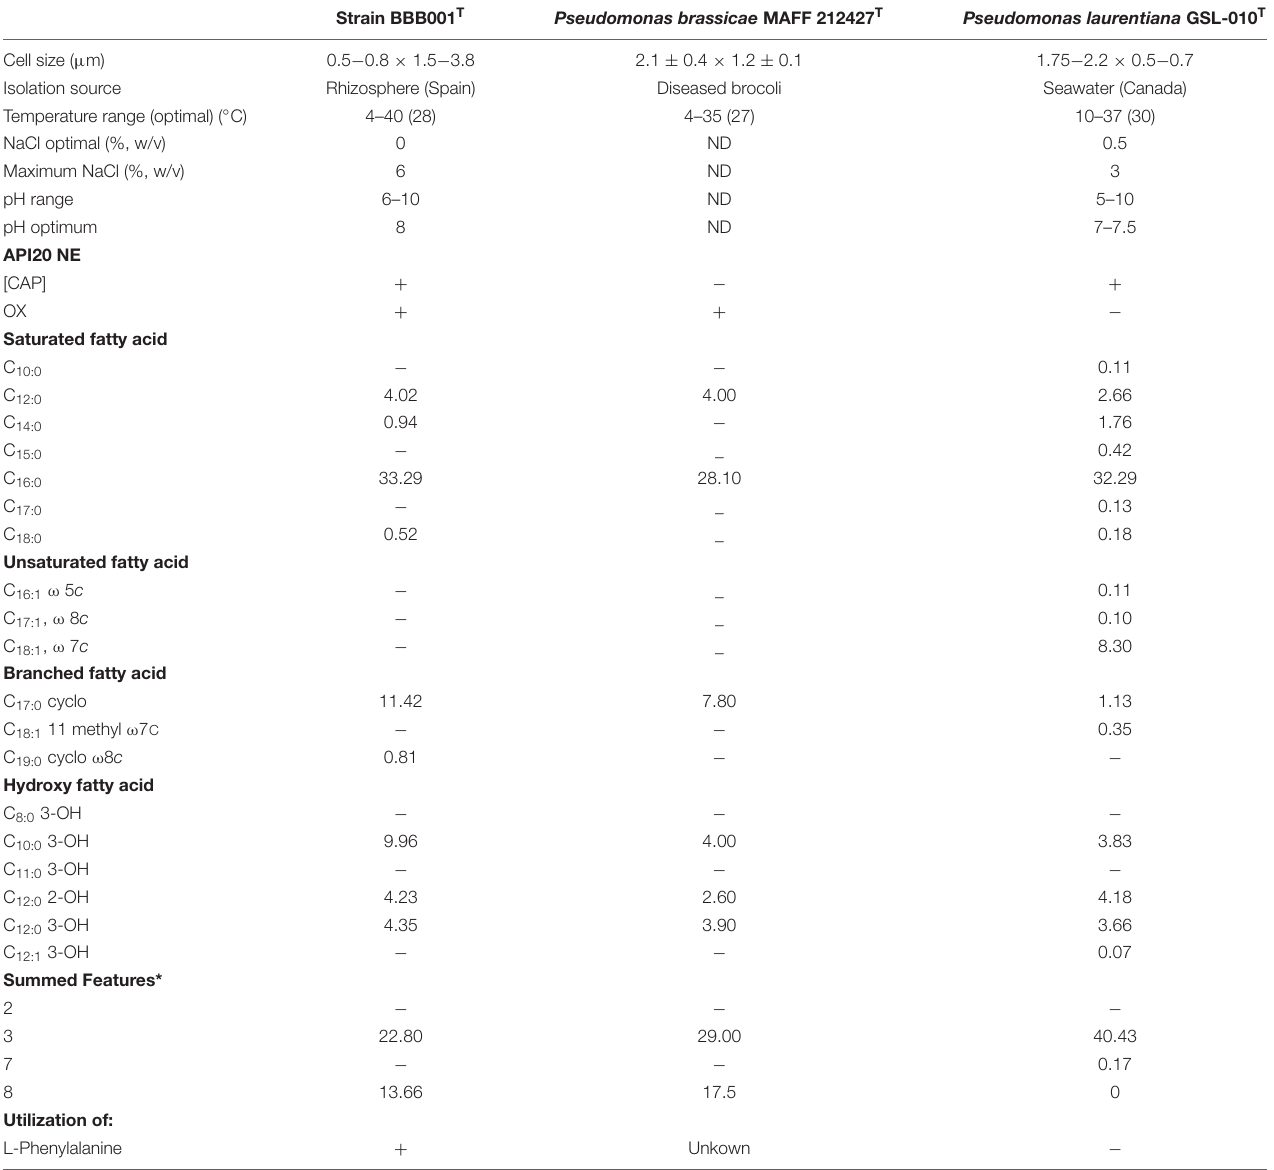
TABLE 1 | Characteristics that differentiate Pseudomonas palmensis sp. nov. from the type strains of the most closely related Pseudomonas species: Pseudomonas brassicae MAFF212427 T (Sawada et al., 2020) and Pseudomonas laurentiana GSL-010 T (Wright et al., 2018).